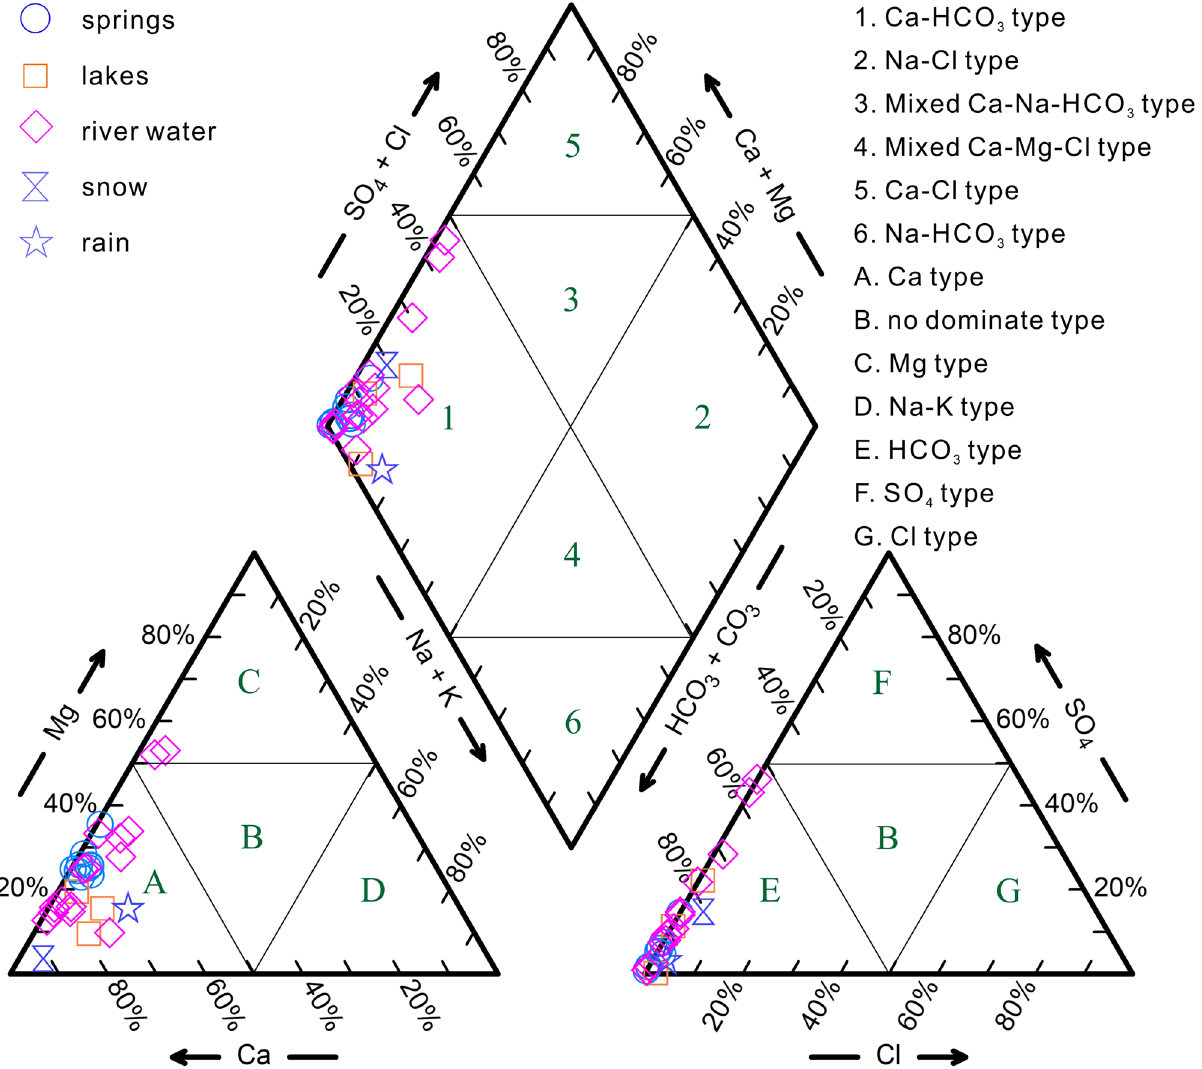
Figure 5. Piper diagram of water samples from within the study area.